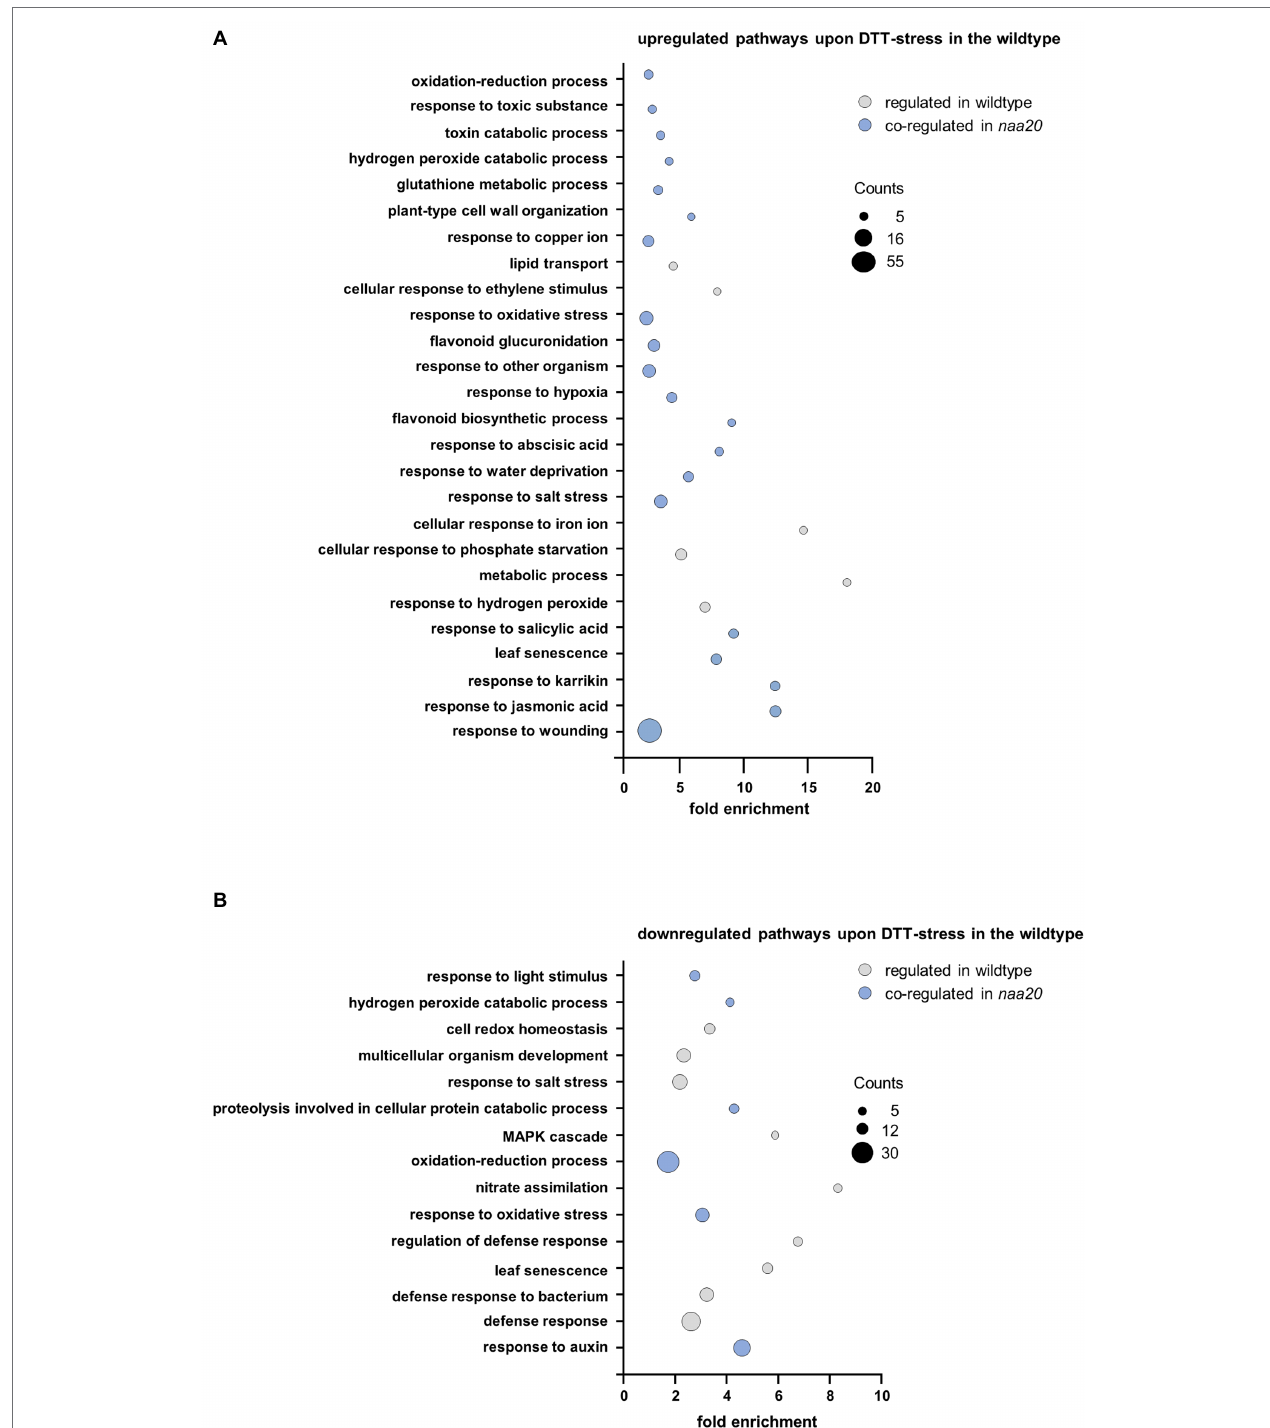
FIGURE 6 | Gene ontology enrichment analysis of DTT-induced changes in the wildtype transcriptome. Total RNA was extracted from 17-day-old naa20 and wildtype seedlings grown on 1 x MS medium with or without 2 mM DTT under short-day conditions ( n = 3). The transcripts were analyzed via an Affymetrix GeneChip. Differentially regulated transcripts (>2-fold up- or downregulated compared to wildtype) were subjected to a gene ontology enrichment analysis performed with the DAVID Bioinformatics Resources tool v.6.8 (https://david.ncifcrf.gov/tools.jsp). Among the differentially regulated transcripts, genes involved in the depicted pathways were significantly (>2-fold, p < 0.05) enriched. The size of the bubbles corresponds to the number of regulated transcripts involved in the depicted pathways. The color code indicates pathways that were regulated in the same direction by DTT treatment in the wildtype and the naa20 mutation (blue) or not co-regulated (gray). (A) Downregulated transcripts in wildtype upon DTT treatment. (B) Upregulated transcripts in wildtype upon DTT